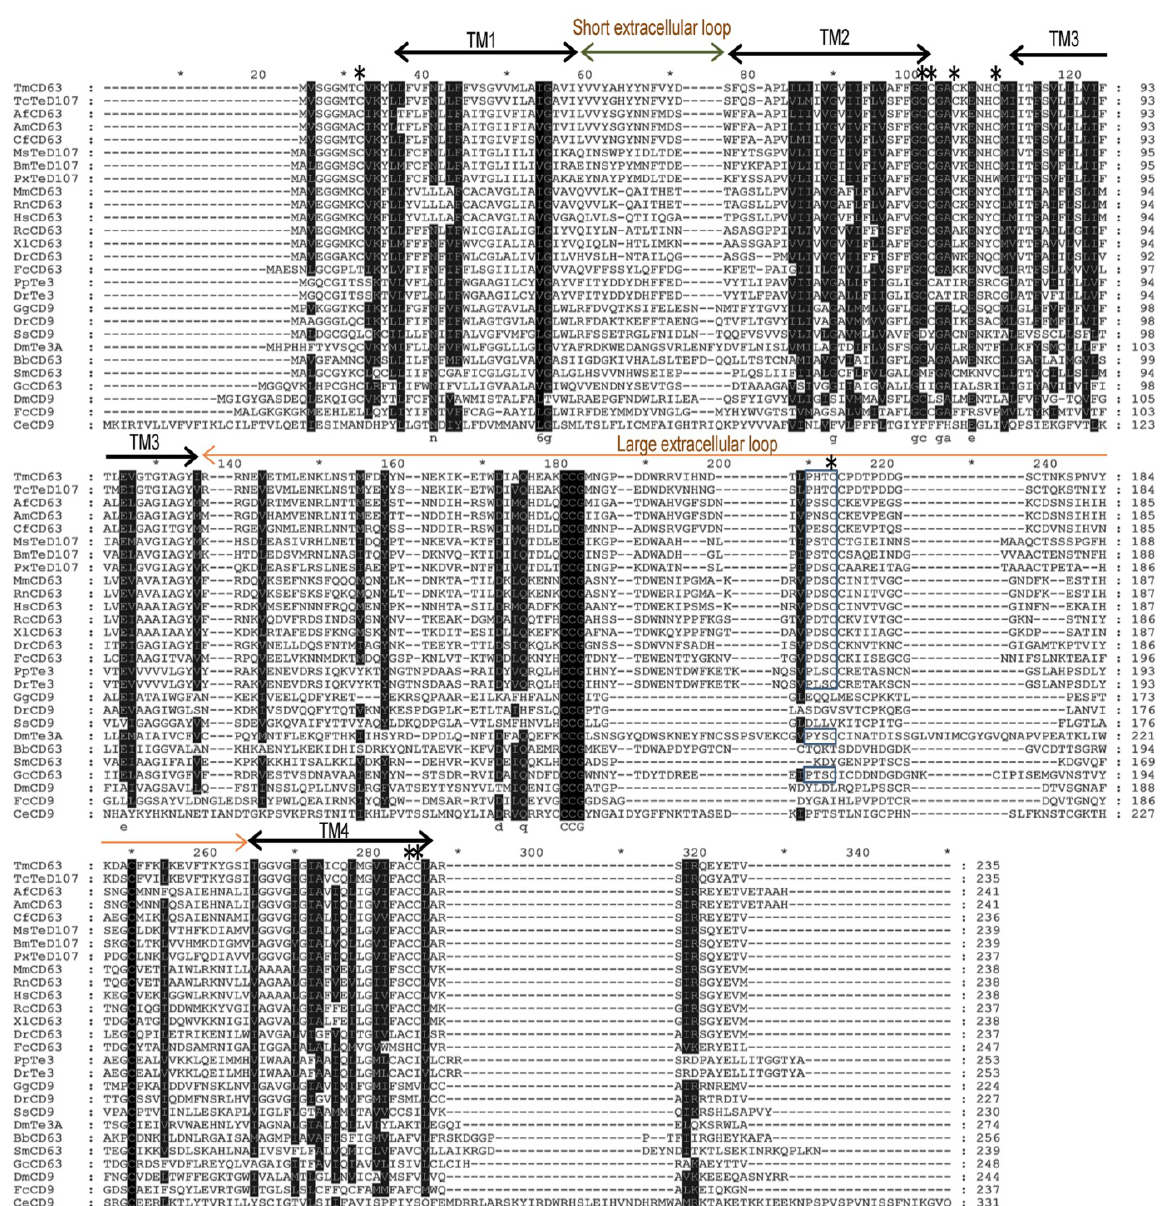
Figure 3. Sequence alignment of tetraspanin family members at the amino acid level. Tetraspanin sequences from various animal groups including insects were extracted using BLASTP program at NCBI. Alignment was carried out using ClustalX 1.83 program and further annotated by GeneDoc software. Identical residues of sequences including the highly conserved “Cys-Cys-Gly” motif are shown in black. The “Pro-X-Ser-Cys” motif is boxed. The transmembrane (TM) domains, short and large extracellular loops are indicated for the sequences. The predicted palmitoylation cysteine residues are indicated by